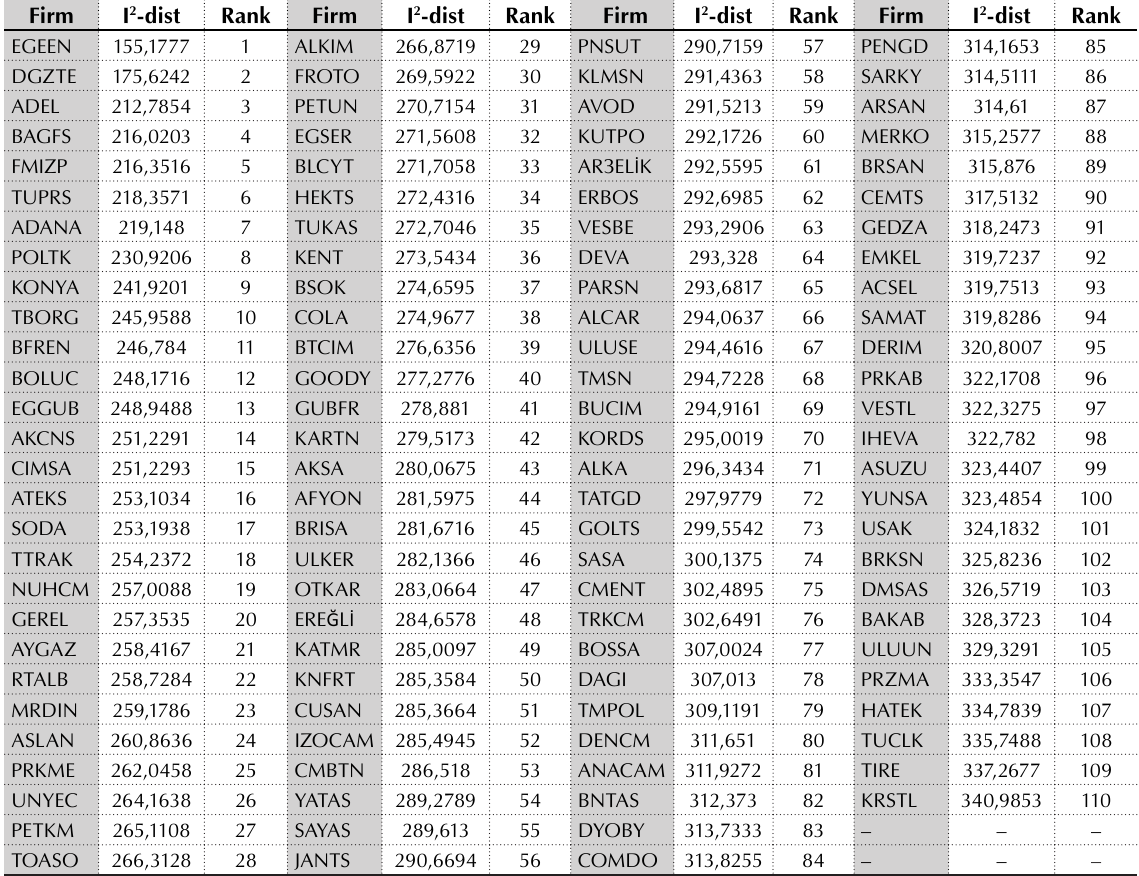
Table 4. The results of the I 2 -distance method final